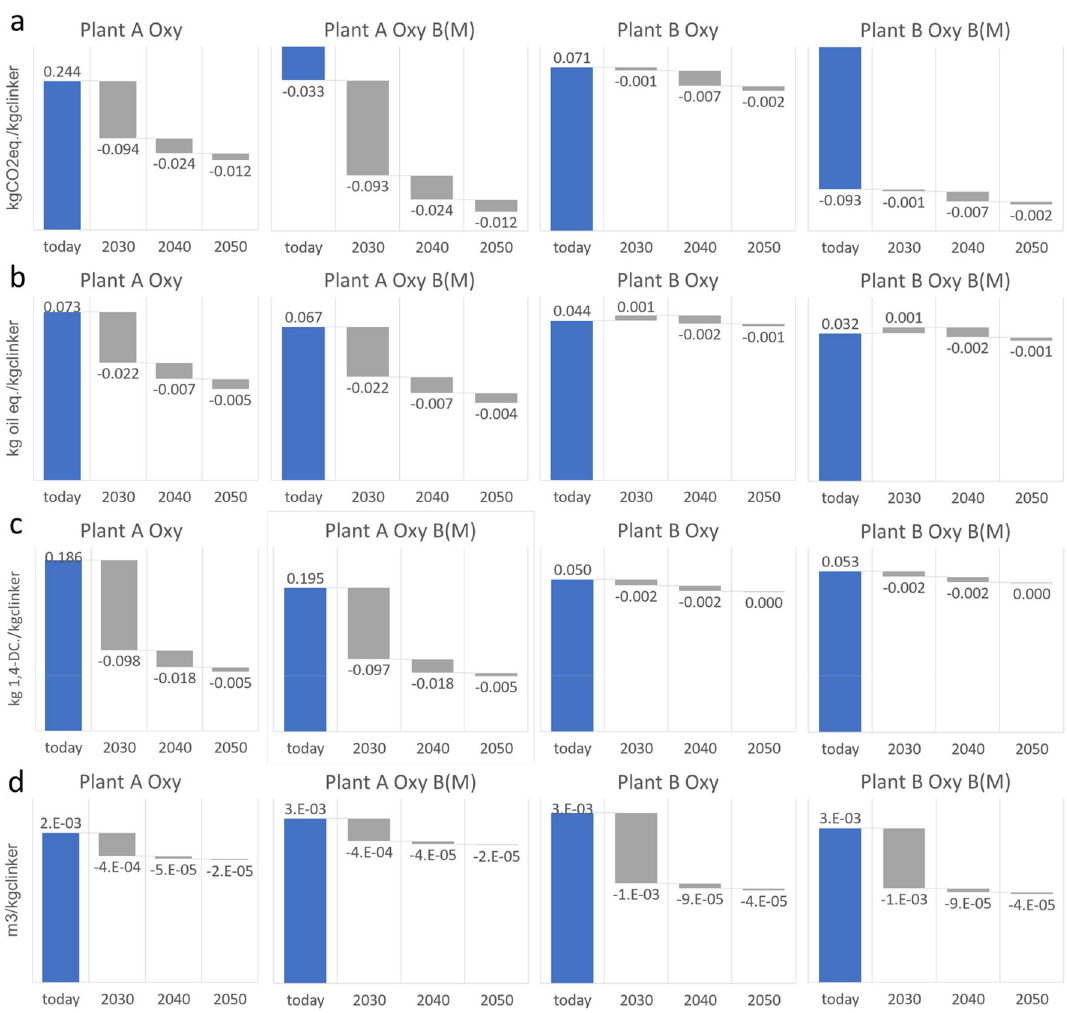
Figure 4. Changes in the environmental impacts of selected oxyfuel CCS cement clinker production with projected future electricity systems. Cases indicates with B(M) consider increased use (66–74% of fuels) of miscanthus biomass as alternative fuel. Impacts on climate change (GWP100) ( a ), fossil depletion potential (FDP) ( b ), human toxicity (HT) ( c ), and water depletion potential (WDP) ( d ). Note the variation of the y axis scales in the different